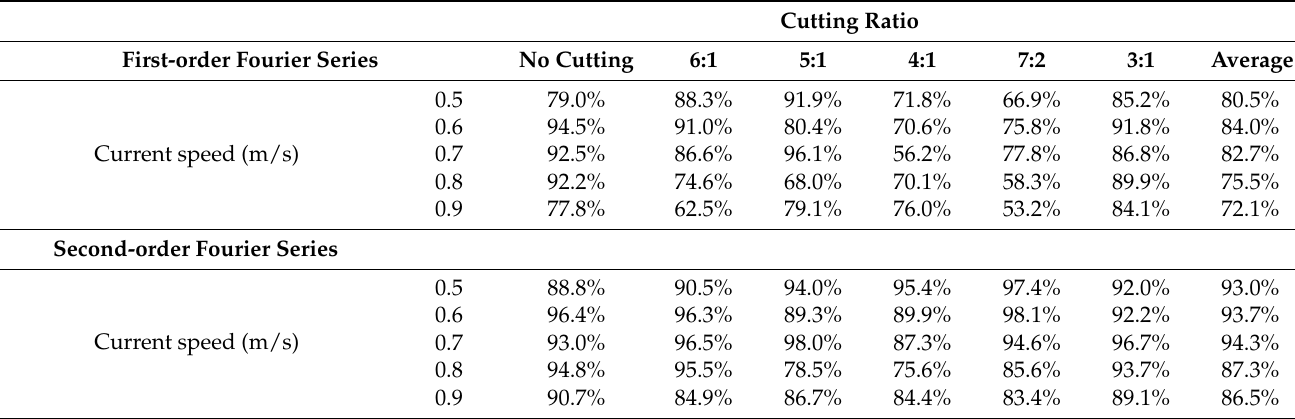
Table 2. Correlation of measured value and fitted value of the end point height for codends by the Pearson product-moment correlation